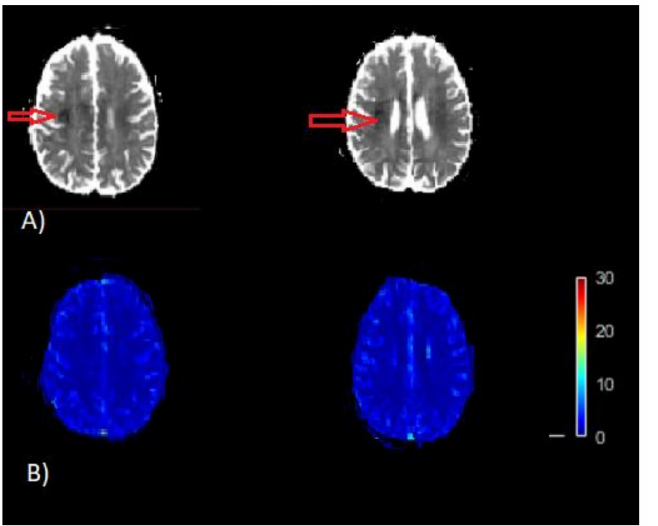
Figure 1. Example of misleading perfusion parameter maps. ( A ) Apparent diffusion coefficient (ADC) image (mm 2 /s). The dark region on ADC image thresholded by ADC ≤ 620 × 10 − 6 mm 2 /s is the infracted core (red arrow) on the map. ( B ) CBF map (bottom) [mL/100 g/min]. This CBF map does not indicates the infract region as represented on the ADC map, which is a result of inaccurate quantification of